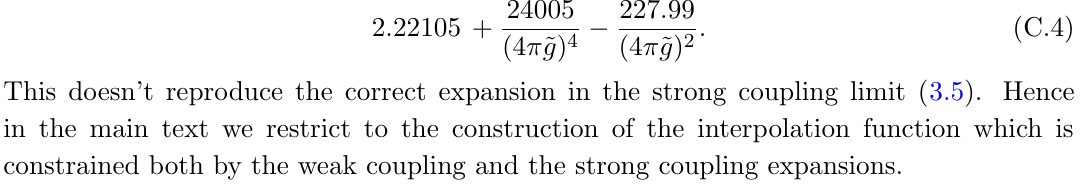
Figure 15. Interpolating function with non-planar correction (green) and without non-planar correction (blue) with S-duality constraint on the weak coupling data only. interpolating function (using weak coupling data only) for cusp anomalous dimension at N=2. E(cid:11)ect of adding non-planar data is also shown in the (cid:12)gure. The strong coupling expansion is given by taking large ~ g expansion of